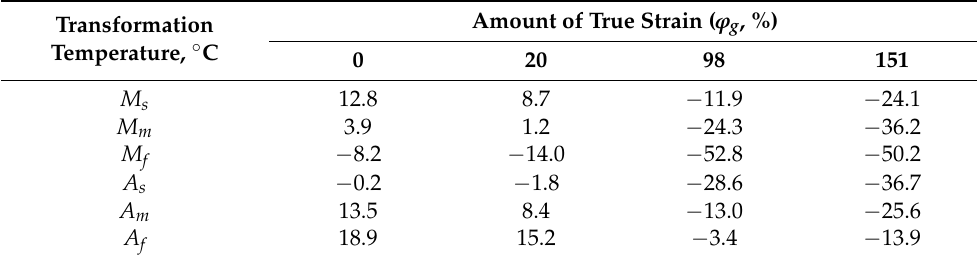
Table 1. Table 1. Values of transformation temperatures of ausforming-treated alloy.